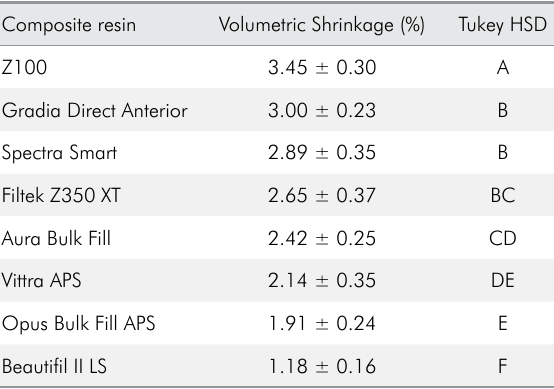
Table 3. Percentage volumetric shrinkage (mean ± standard deviation) at 60 min.